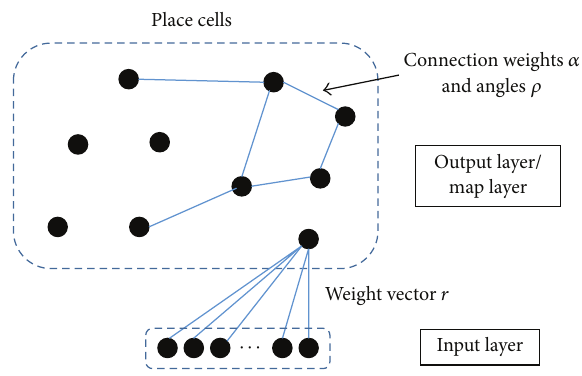
Figure 5: Neural network structure as a result of learning connec- tivity between place cells. The input layer represents input from the robot’s sensors